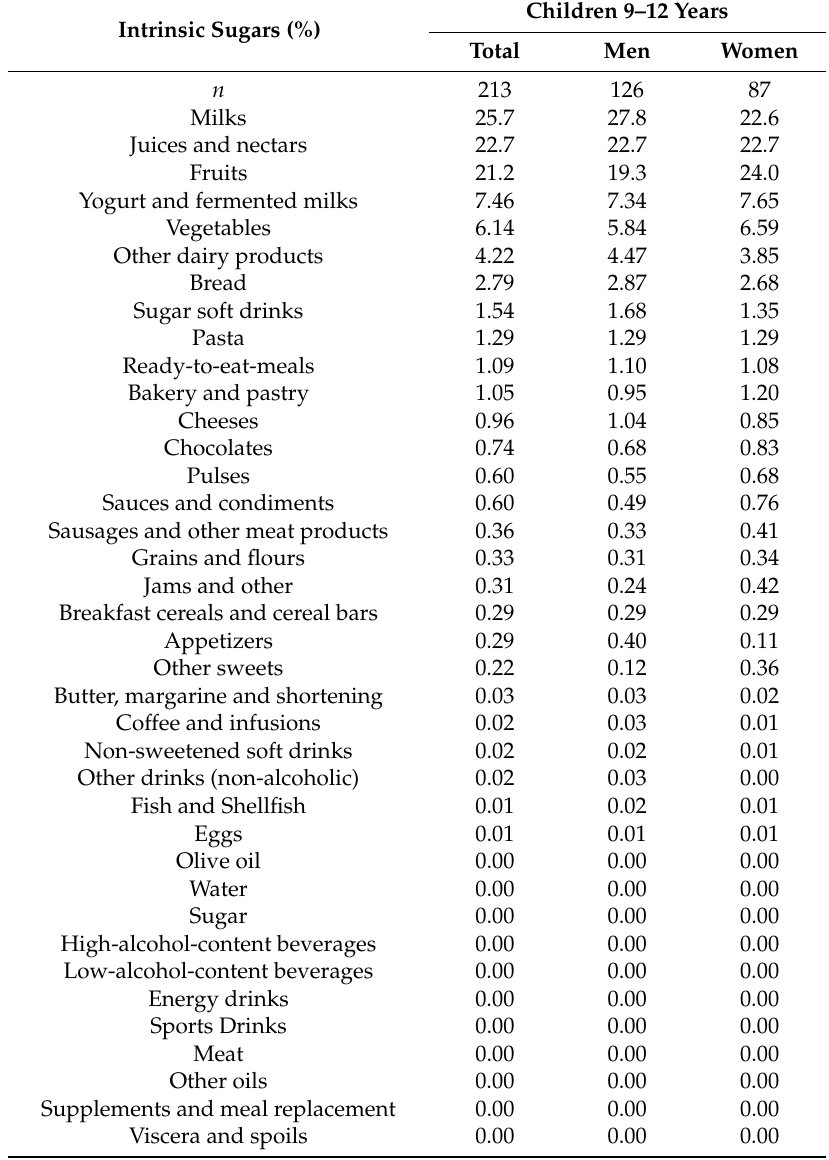
Table 7. Dietary sources of intrinsic sugars (%) from food and beverage subgroups in the ANIBES Study Spanish population aged 9 to 12 years: